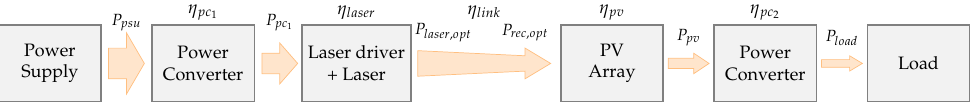
Figure 23. Efficiency of an LPT